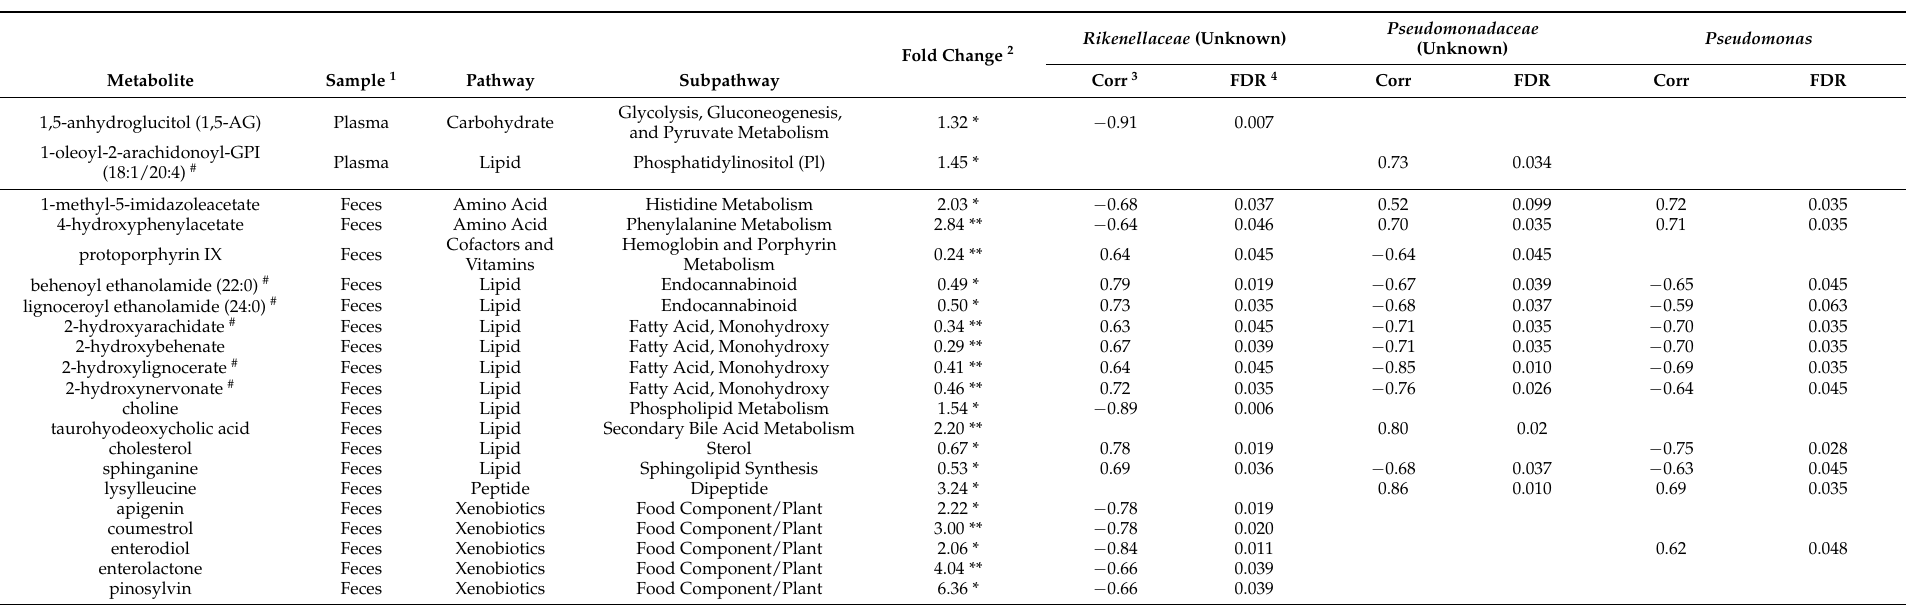
Table 1. Correlation analysis between fructose-responsive fecal microbiota and metabolites in plasma and feces of DBA